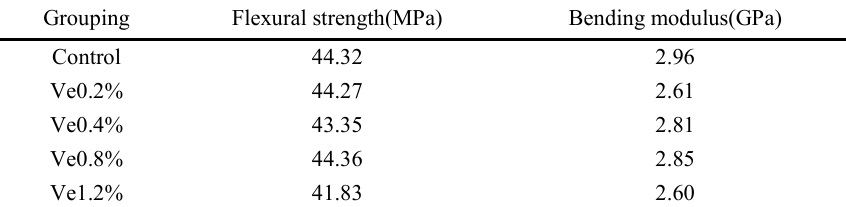
Table 1. Flexural properties of all composites before